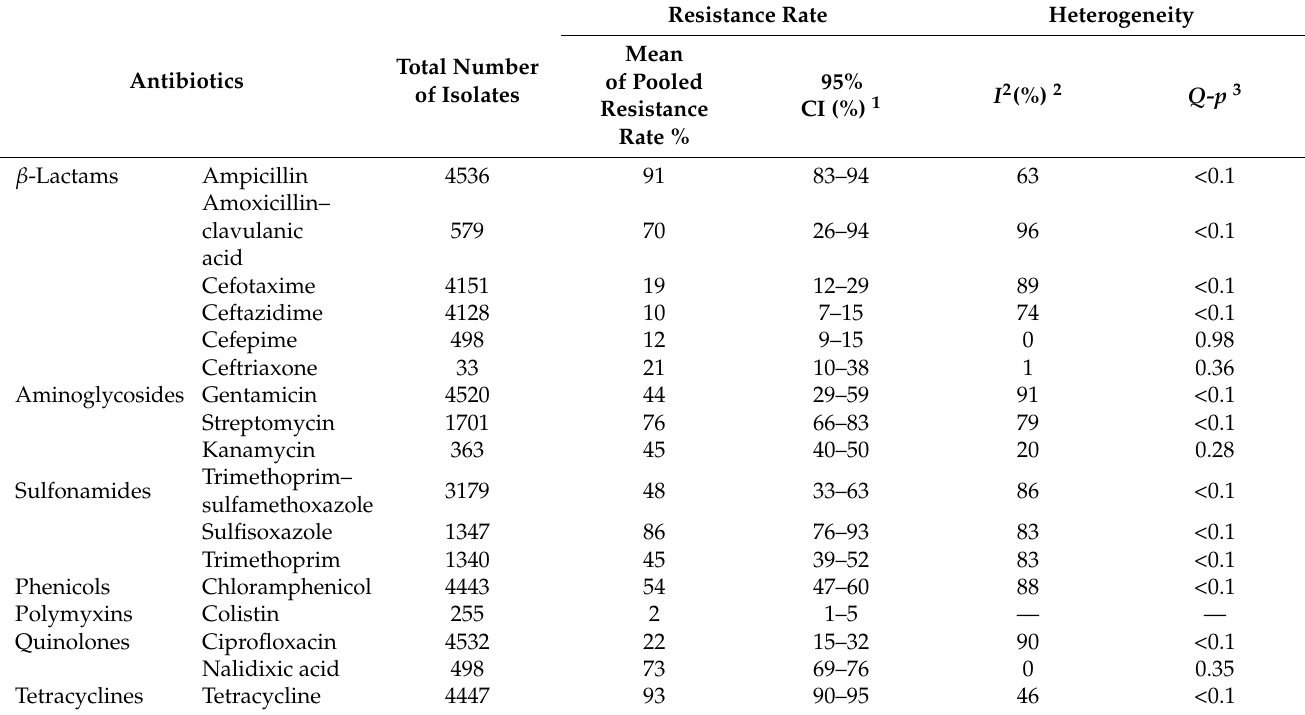
Table 1. Meta-analysis results concerning antibiotic resistance in S . 1,4,[5],12:i:- isolates in